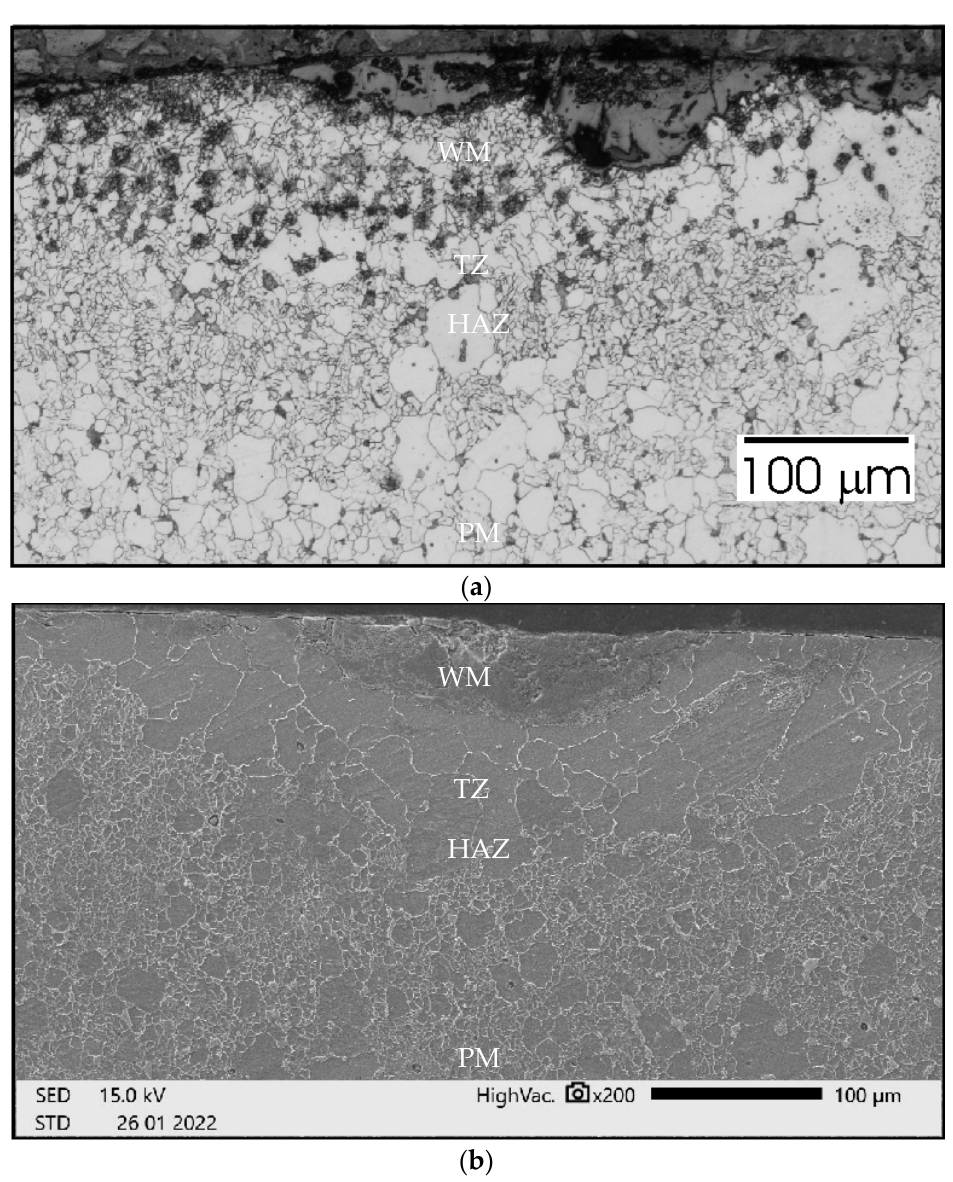
Figure 26. Sample no 4 reached without acoustic vibration: ( a ) Metallography and ( b ) SEM; PM—parent metal, HAZ—heat affected zone, TZ—transition zone, WM—weld metal.